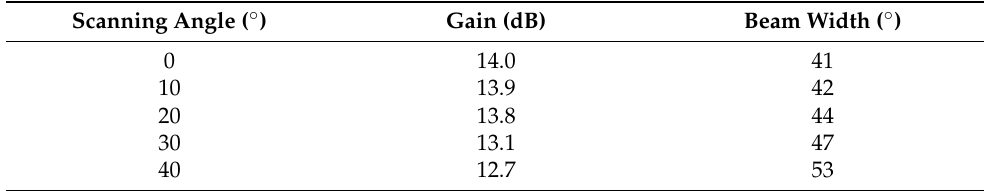
Table 2. Beam performances during scanning of the NDCPPA model verification prototype.